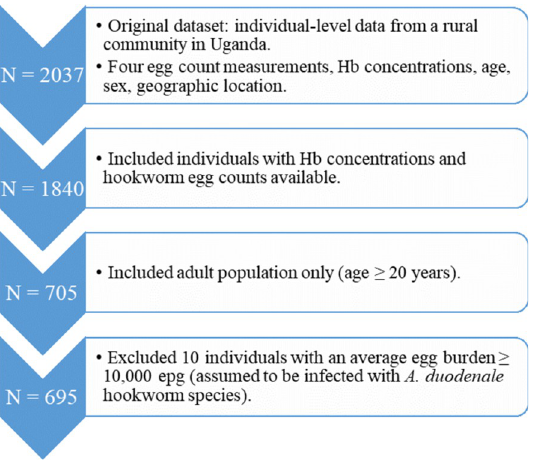
Fig 1. Flowchart describing the process of data selection for the statistical